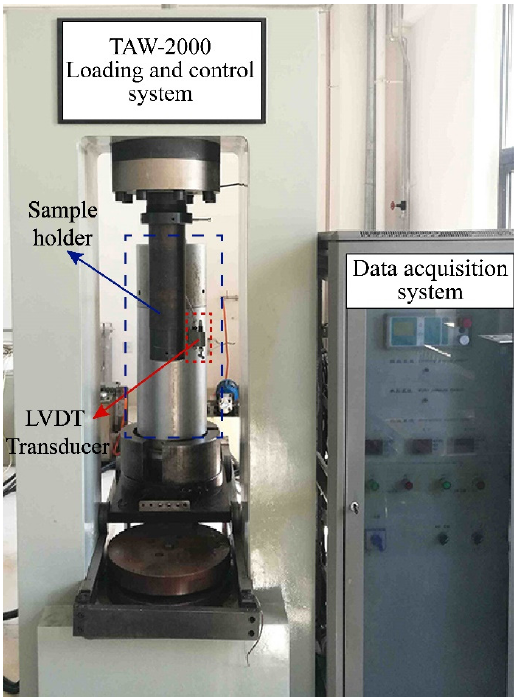
Figure 2. Experimental system diagram.